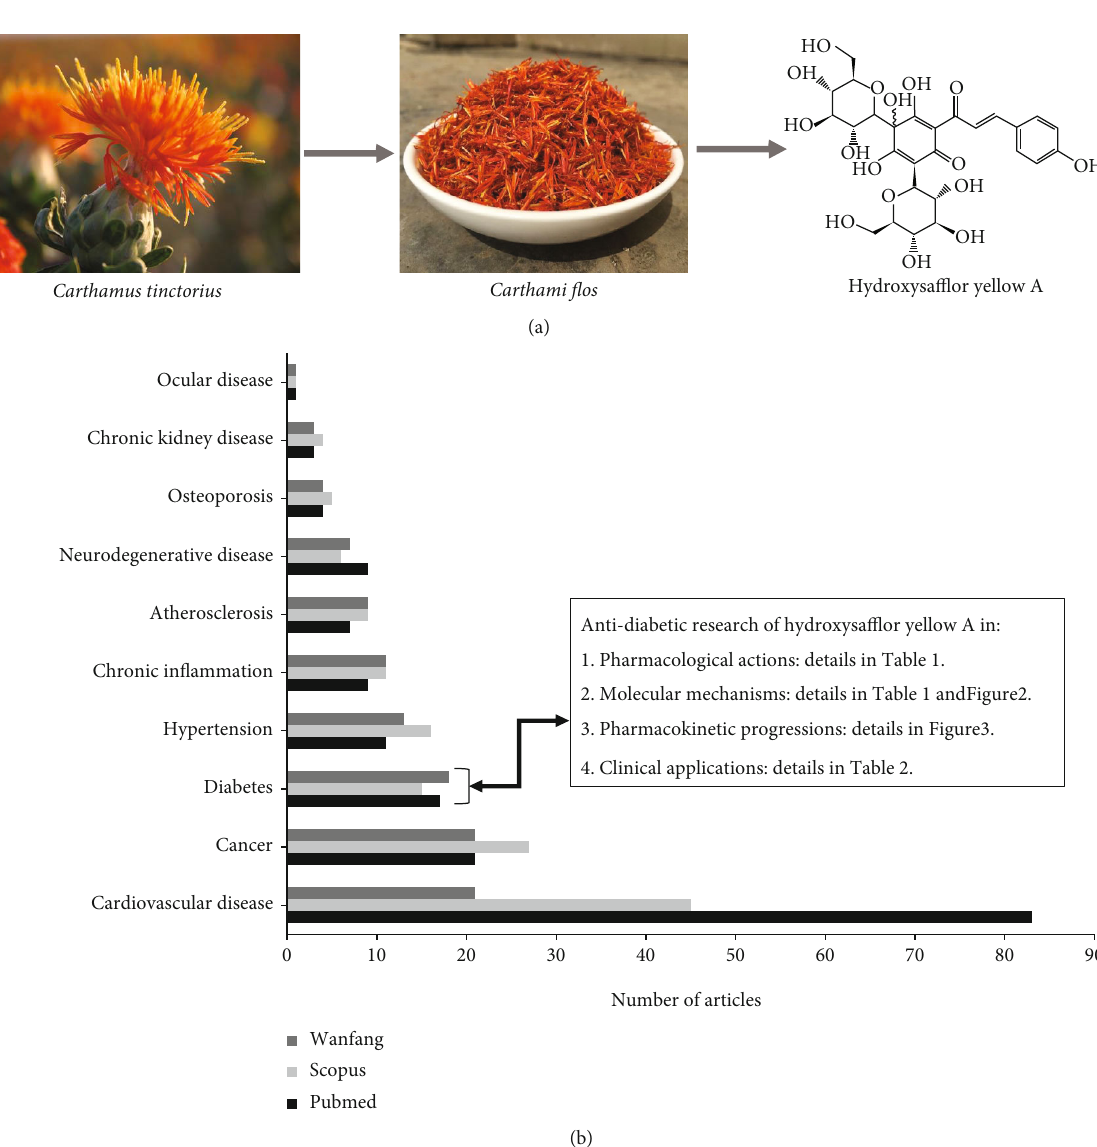
Figure 1: The source, structure, and literature research of hydroxysa ffl or yellow A: (a) the source and structure of hydroxysa ffl or yellow A; (b) the research articles of the top ten diseases related to hydroxysa ffl or yellow A. Abbreviation: Wanfang: Wanfang